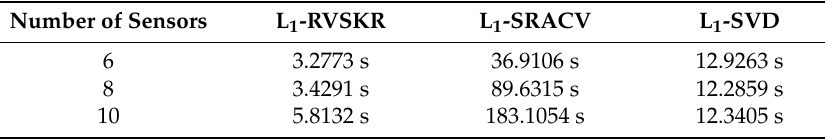
Table 1. The running time versus the number of sensors.